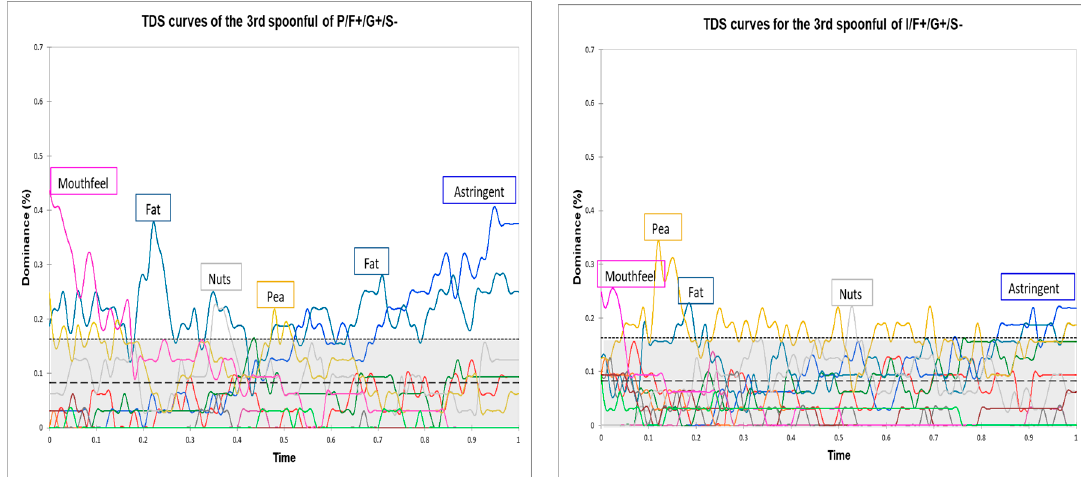
Figure 5. Standardized TDS curves for the two pea protein-based beverages (I/F+/G+/S − and P/F+/G+/S) evaluated using multi-intake TDS profiling. The curves depict attribute dominance over time (i.e., following the first spoonful, the second spoonful [after consuming 60 mL], and the third spoonful [after consuming 120 mL]). The two horizontal lines indicate the chance level and the significance level (see Figure 4). Abbreviations: I = isolate, P = pellet, F+ = 1.5% oil, G+ = 0.5% gellan gum, and S − = 0.08% salt.